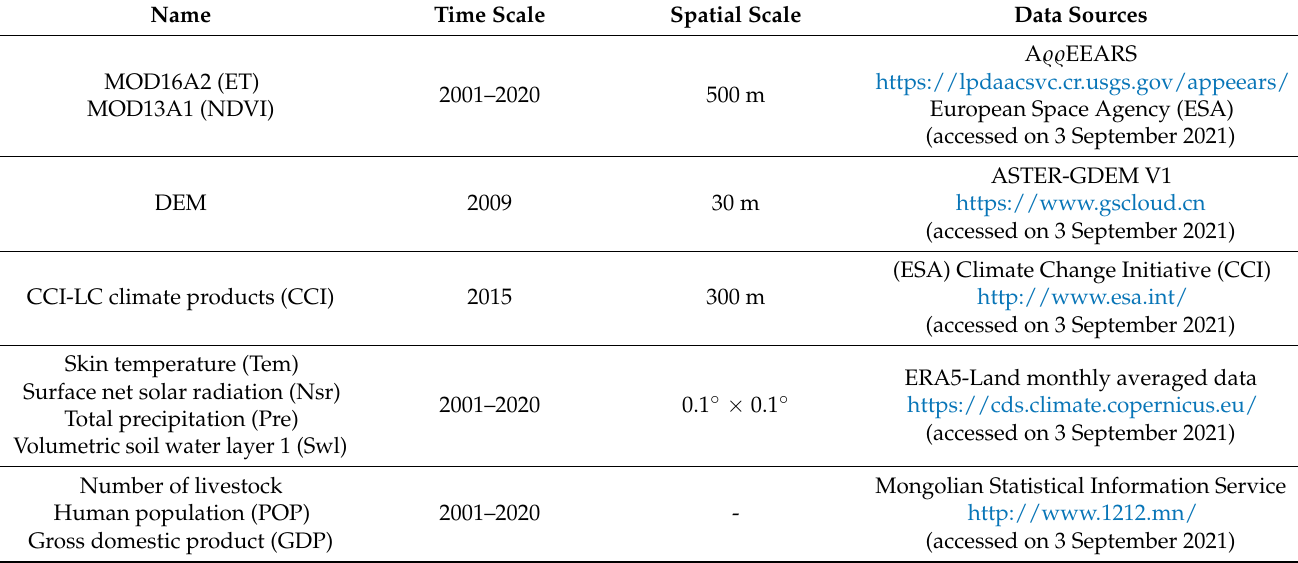
Table 1. List of data sources used in this